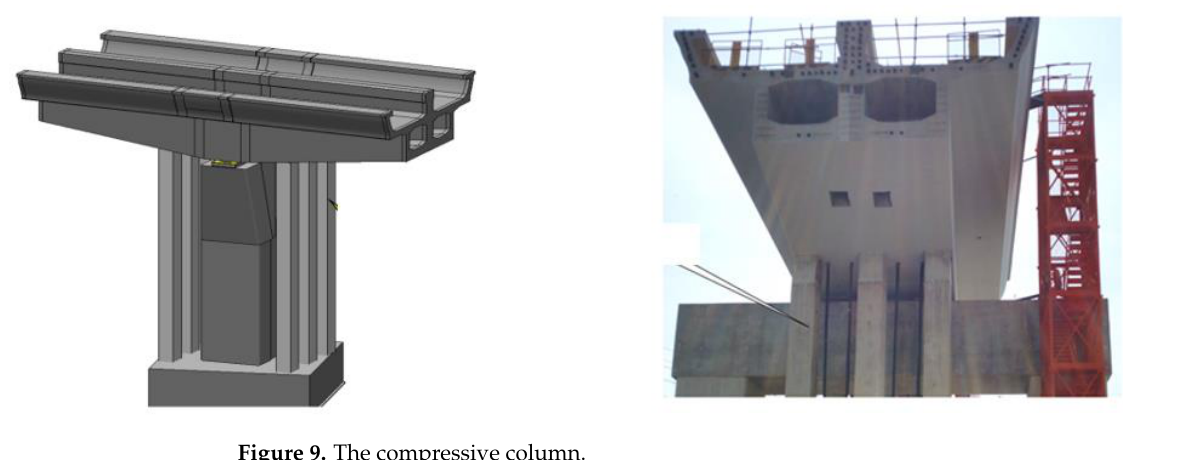
Figure 9. The compressive column.